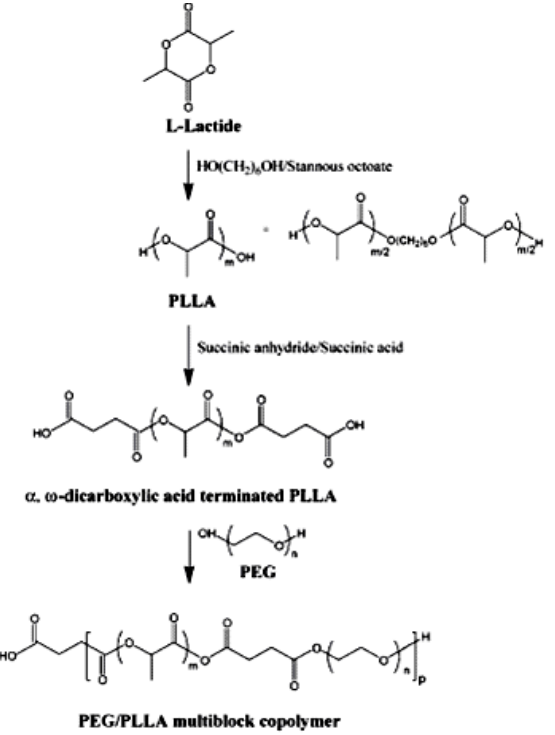
Figure 2. Synthesis of PEG/PLA Multiblock Copolymer [63].